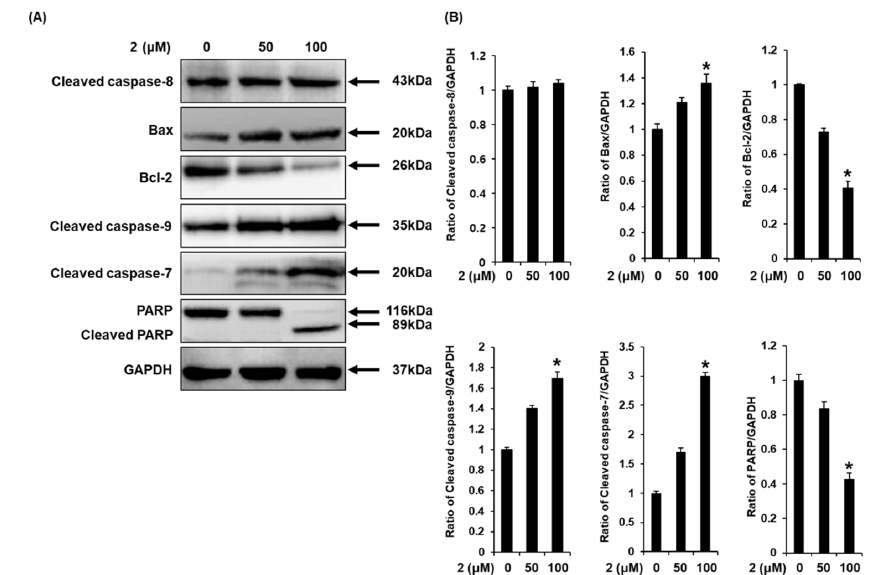
Figure 6. Effects of aviculin ( 2 ) on the expression of apoptosis-related proteins in MCF-7 human breast cancer cells. ( A ) Representative images of Western blotting for cleaved caspase-8, Bax, Bcl-2, cleaved caspase-9, cleaved caspase-7, PARP, and GAPDH in MCF-7 cells treated with aviculin ( 2 ) (50 and 100 μM) for 24 h. GAPDH was used as the internal control. ( B ) Each bar graph presents the densitometric quantification of the Western blotting bands. Control cells were treated with 0.5% DMSO. The experiment was performed in triplicate, and the error bars represent the standard deviation of samples ( n = 3). * p < 0.05 compared with the control.